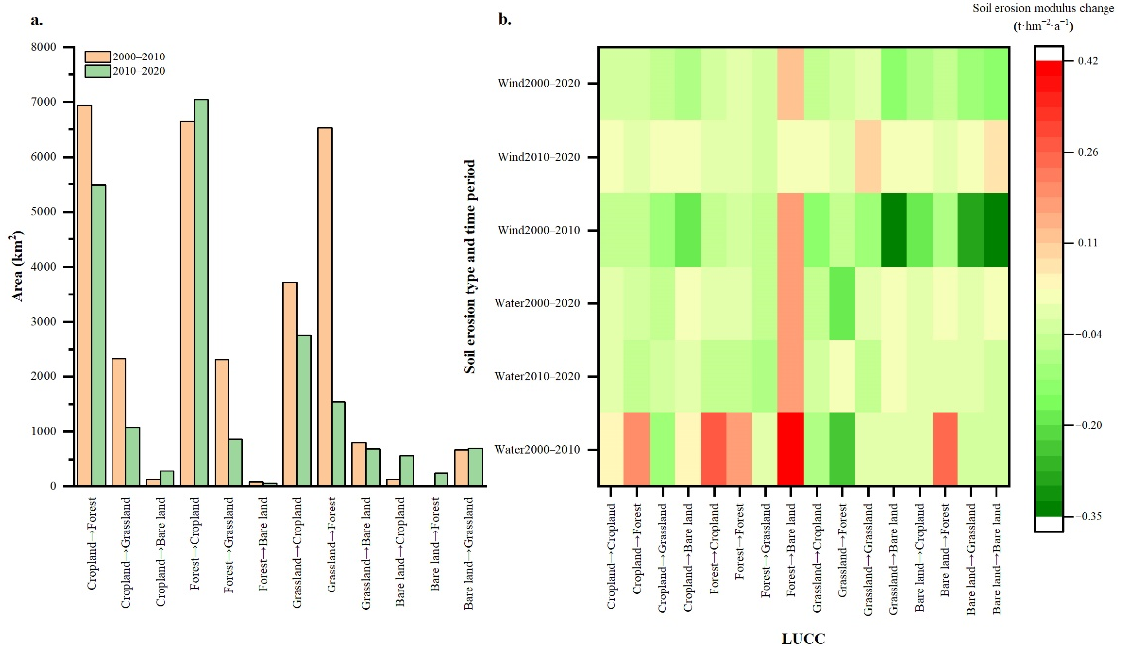
Figure 6. Land use change ( a ) and the relationship between LUCC and change of soil erosion ( b ) in Northeast China from 2000 to 2020.